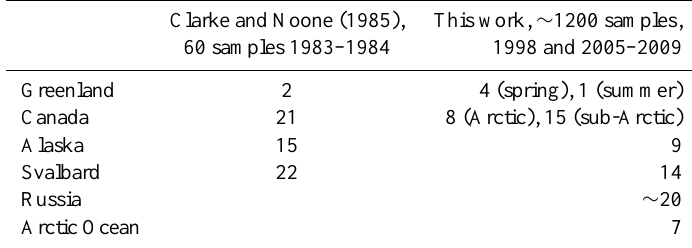
Table 9. A comparison of median estimated BC concentrations in snow (ngg − 1 ) for regions around the Arctic, from a previous study in the 1980’s and from this